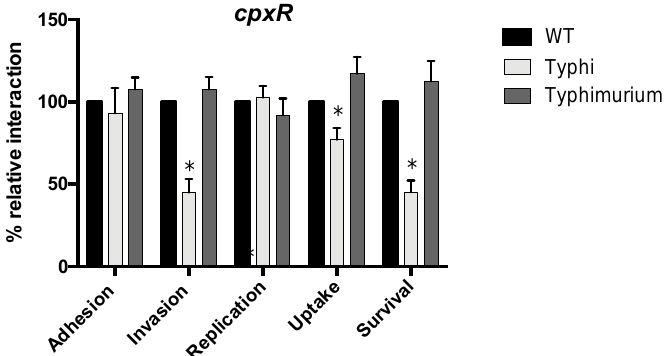
Figure 6. Comparison of the cpxR mutant of S. Typhi and S. Typhimurium. Epithelial INT-407 cells and THP-1 macrophages were infected with S . Typhi ISP1820 strain and S. Typhimurium SL1344 and their isogenic cpxR mutant. Both WT strains are settled at 100 percent. All assays were conducted in triplicate and repeated independently at least three times. The results are expressed as the mean ± SEM of the replicate experiments. Significant differences (* p < 0.0001) compared to the wild-type were determined by the Student’s unpaired t -test.